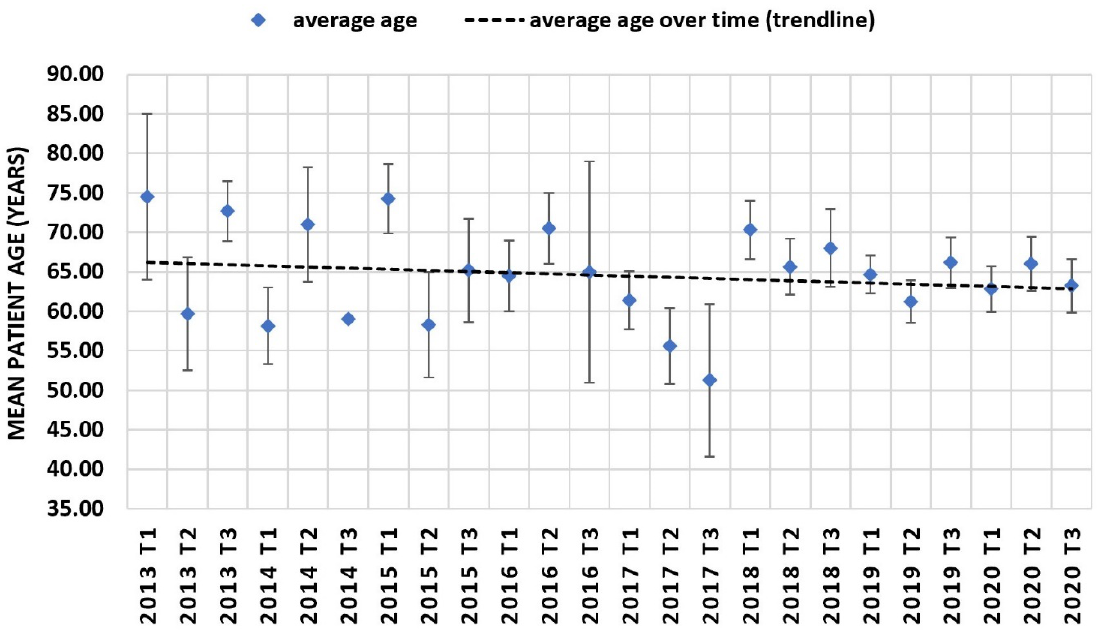
Figure 4. Mean patient age at TLE. Mean patient age at extraction including standard error of the mean for every four-month period and trendline analysis. Only a single patient was recorded for 2014 T3; therefore it is without standard error of the mean.